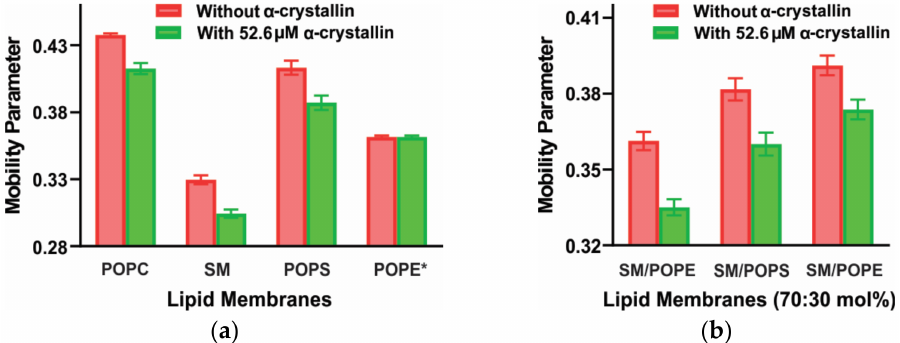
Figure 3. The decrease in the mobility parameter of the lipid (PL and sphingolipid) membranes after α -crystallin binding. ( a ) Individual lipid membranes, i.e., POPC, SM, POPS, and POPE* (where * represents the presence of 30 mol% POPC). ( b ) Two-component lipid membranes, i.e., SM/POPE, SM/POPS, and SM/POPE in 70:30 mol%. The mobility parameter decreases for the individual lipid membranes (POPC, SM, and POPS) and two-component lipid membranes (SM/POPE, SM/POPS, and SM/POPE in 70:30 mol%) with an increase in α -crystallin concentration, representing the decrease in the mobility of the membranes near the headgroup regions due to the increase in the binding of α -crystallin to these membranes. The mobility parameter for the POPE* membrane does not decrease in the presence of α -crystallin, because α -crystallin does not bind to the POPE* membrane. Redrawn with permission from [99,101], Copyright 2021, with permission from Taylor & Francis and